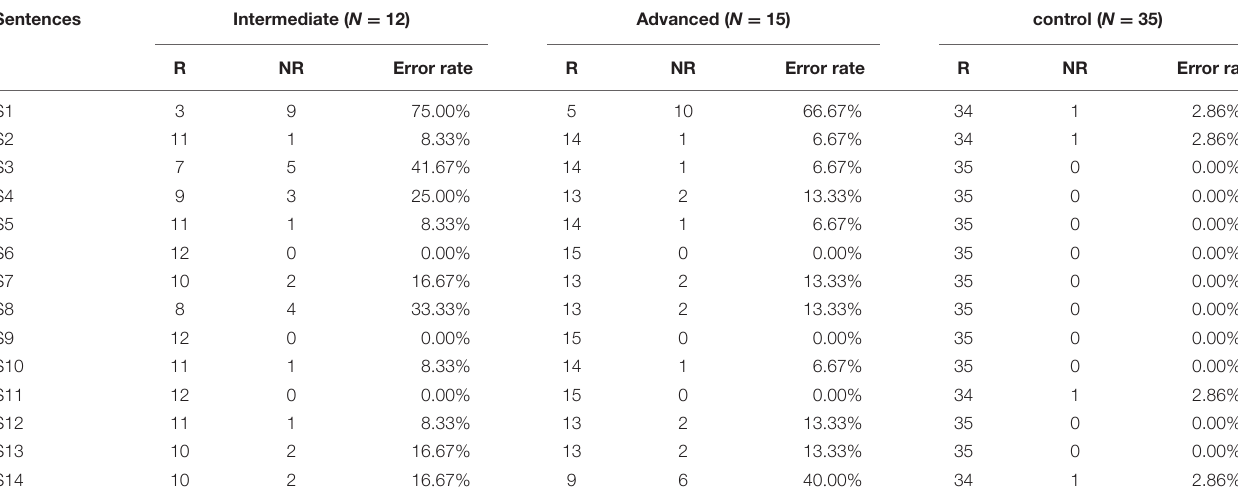
TABLE 3 | Split SC recognition in each testing sentence. Sentences